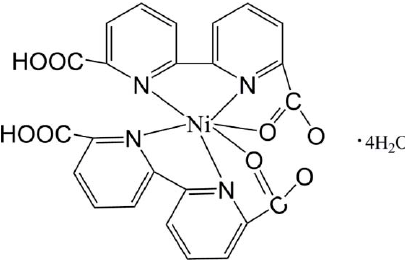
Rigaku Saturn CCD area-detector diffractometer